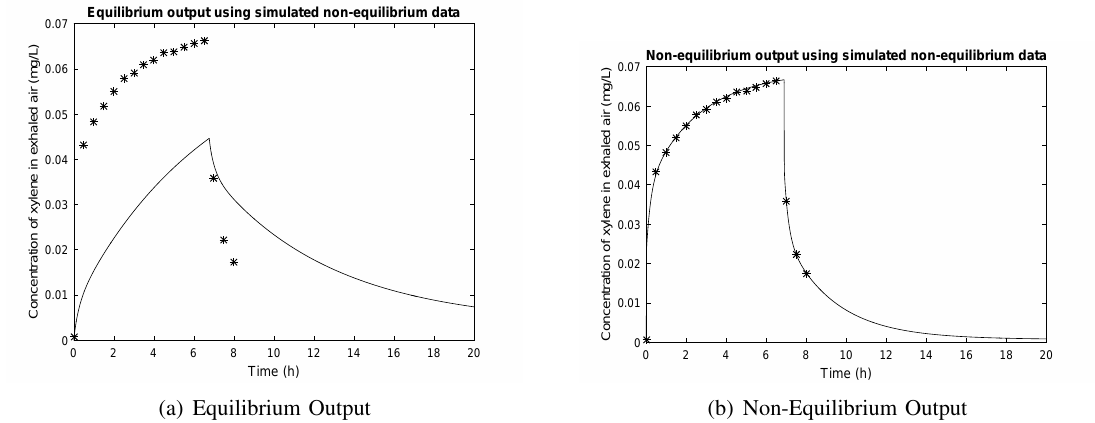
Non-equilibrium output using simulated non-equilibrium data